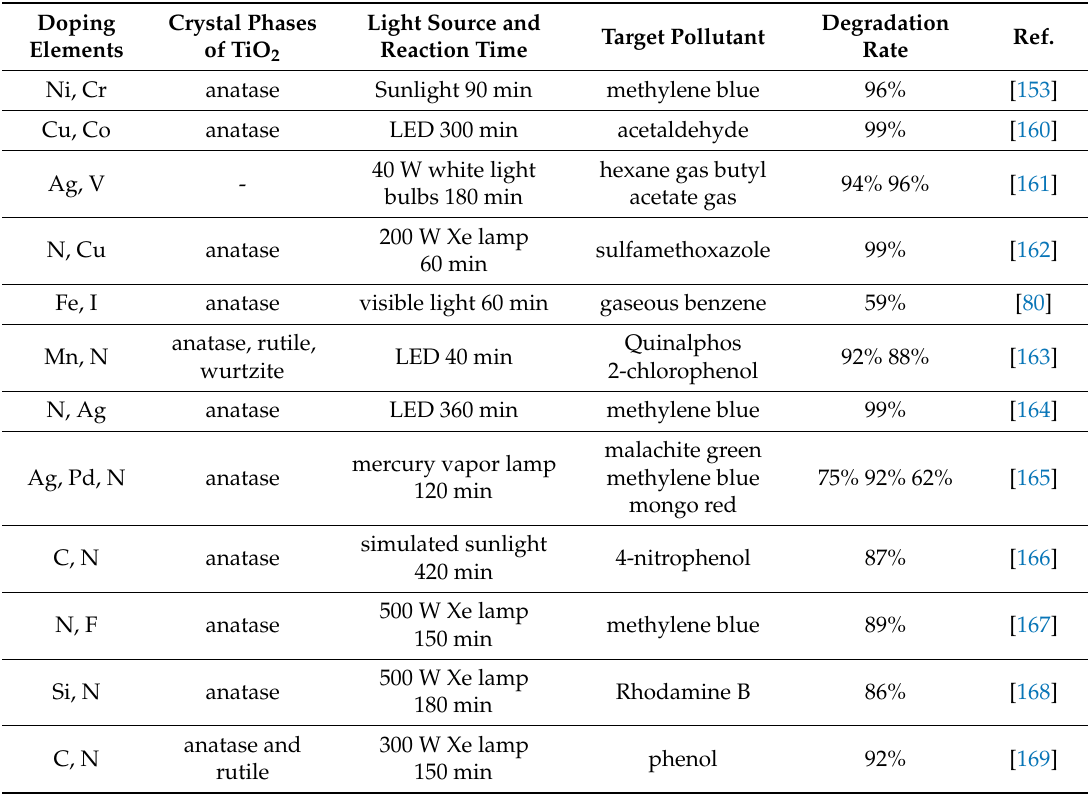
Table 2. The photocatalytic performance of the co-doped TiO 2 in treating